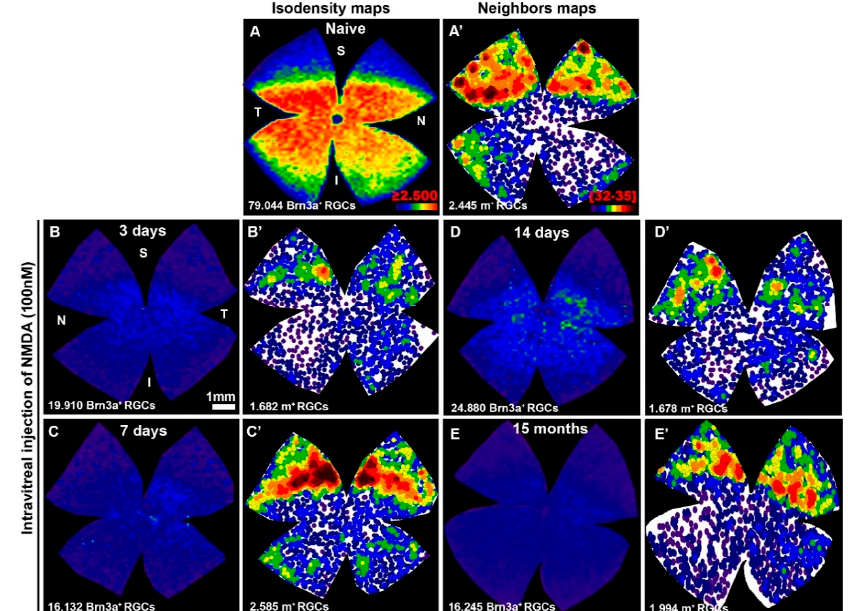
Figure 3. ( A – E ) Isodensity maps showing the retinal topography of Brn3a + RGCs in intact retinas ( A ) or in representative retinas analyzed at 3 ( B ), 7 ( C ), 14 ( D ) days, or 15 ( E ) months after intravitreal injection of 100 nM NMDA. ( A’ – E’ ) Neighbor maps illustrating the distribution of m + RGCs in the same retinas shown in ( A – E ). Isodensity maps color scale ranges from 0 (purple) to ≥ 2500 (red) cells / mm 2 . Neighbor map color scale, where each color represents an increase of 4 neighbors in a radius of 0.22 mm from purple (0–4 neighbors) to dark red (32–35 neighbors). Below each map is shown the total number of Brn3a + RGCs or m + RGCs counted. Note: S = superior; I = inferior; N = nasal; T = temporal. Scale bar = 1